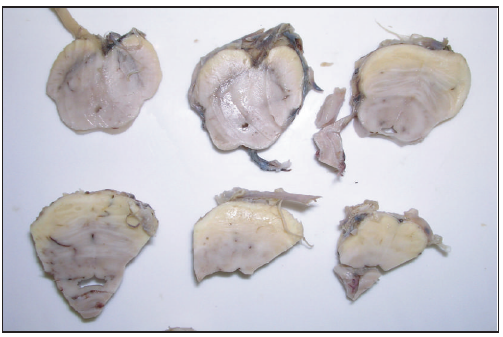
Figure 3: Liposarcoma in subarachnoid